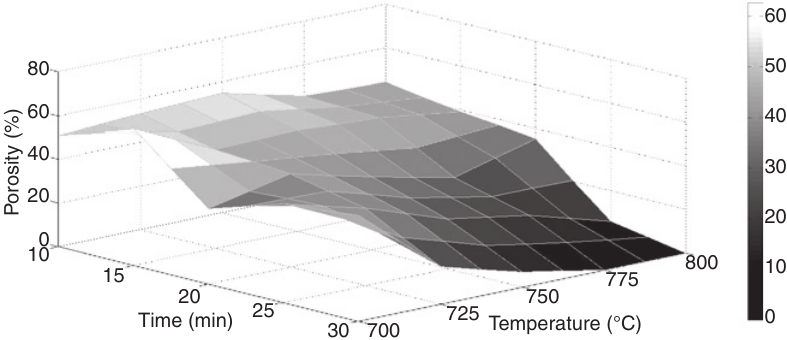
Figure 5: MG30 porosity as a function of sintering time and